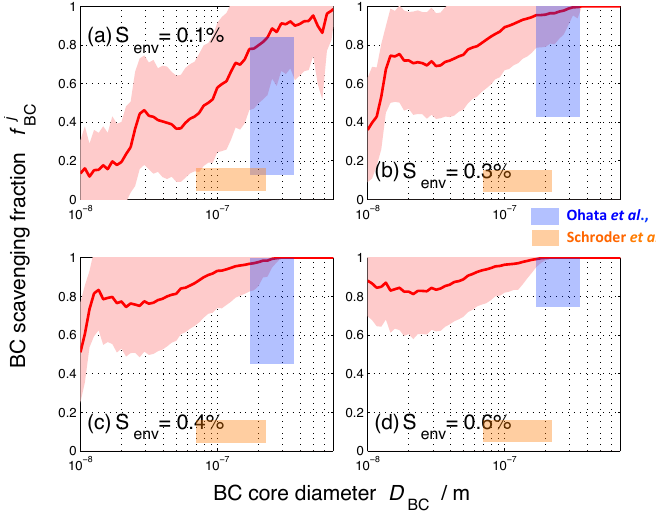
Figure 3. The size-resolved nucleation-scavenged black carbon (BC) mass fraction, f j black carbon core diameter, D BC , at four selected supersaturation values: 0.1%, 0.3%, 0.4%, and 0.6%. The solid line represents the average over the 384 populations, and the color shading indicates one standard deviation. The orange and blue shaded boxes indicate the values that were obtained from field studies by [19,20],